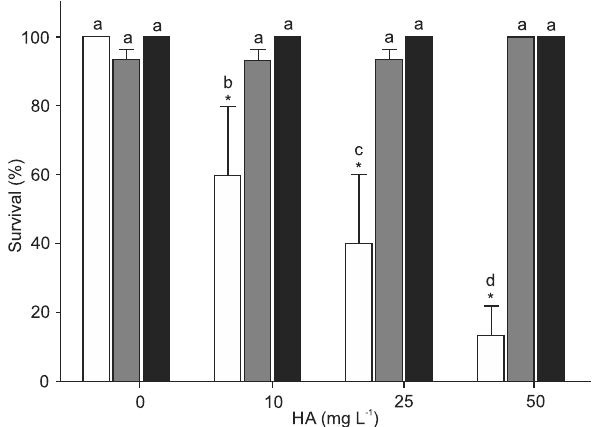
Figure 1. Effect of humic acid (HA) and pH on survival of silver catfish ( Rhamdia quelen ). Different letters indicate significant dif- ference between HA concentrations at the same pH. * indicate significant difference from pH 7.0 at the same HA concentration (p < 0.05). Mean values ± SE (n = 6-15/group). ( (cid:133) ) pH 4.0, ( (cid:132) ) pH 4.2, ( (cid:132) ) pH 7.0.